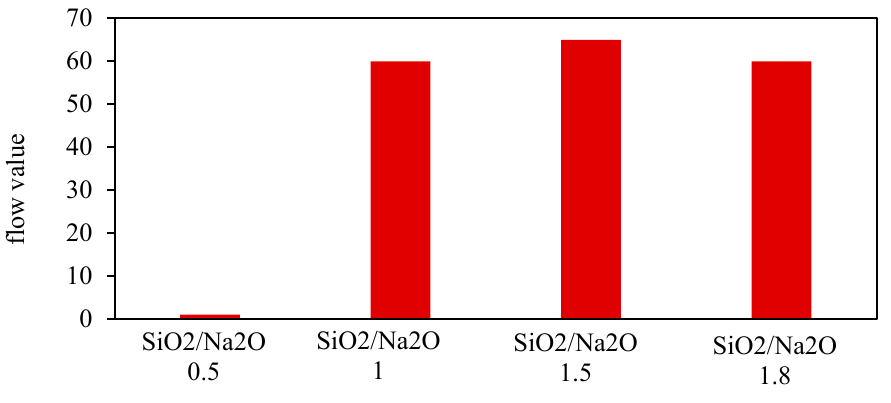
Figure 8. Flow value vs. SiO 2 /Na 2 O ratio in activator [39].